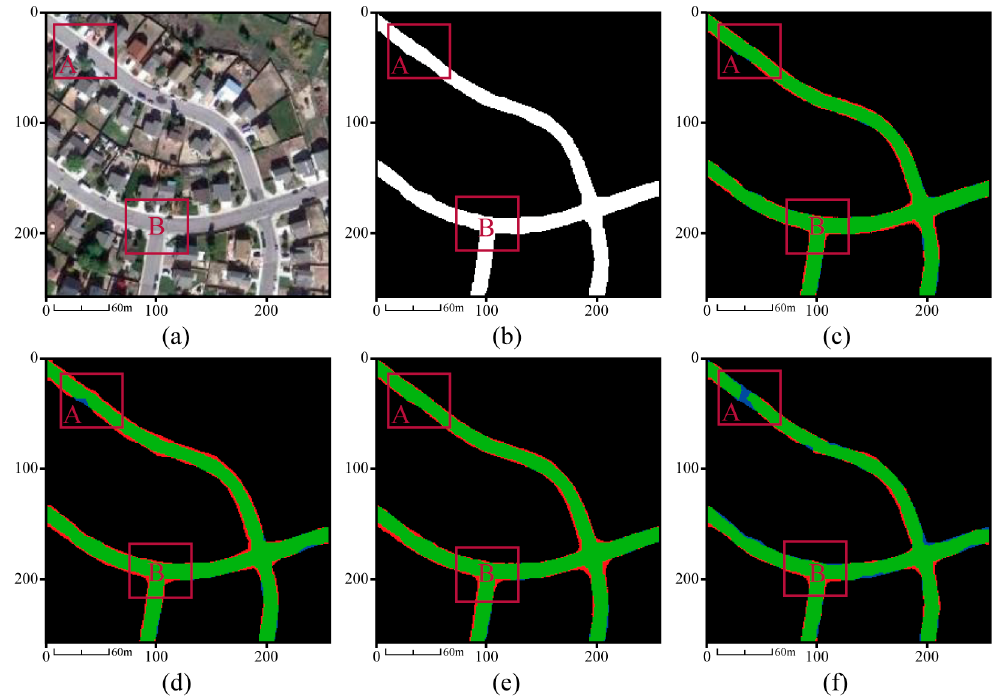
Figure 9. Visual comparisons of road extraction results with different comparing algorithms. ( a ) The original remote sensing image. ( b ) The corresponding ground truth image of this region. ( c ) The results using the GL-Dense-U-Net model. ( d ) Results of FCN. ( e ) Results of U-Net. ( f ) Results of DeepLab V3+. Green, red and blue represents the TP, FP and FN, respectively.